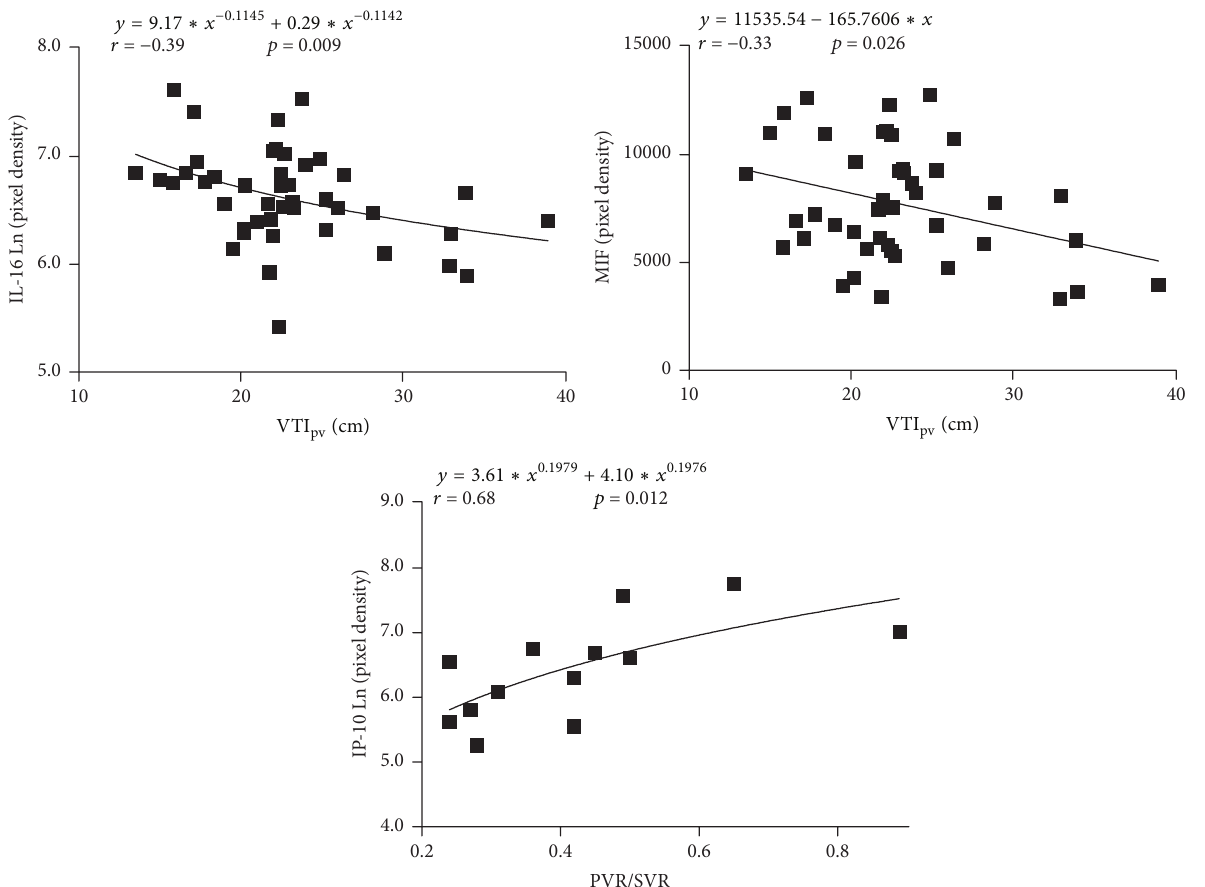
Figure 2: Serum concentration of inflammatory mediators (pixel density of chemiluminescence signal) at different levels of pulmonary blood flow (VTI PV , velocity-time integral of blood flow in pulmonary veins, echocardiographic assessment, 𝑛 = 44 ) and pulmonary vascular resistance (PVR/SVR, pulmonary-to-systemic vascular resistance ratio, cardiac catheterization, 𝑛 = 13 ). IL-16: interleukin 16; MIF: macrophage migration inhibitory factor; IP-10: interferon gamma-induced